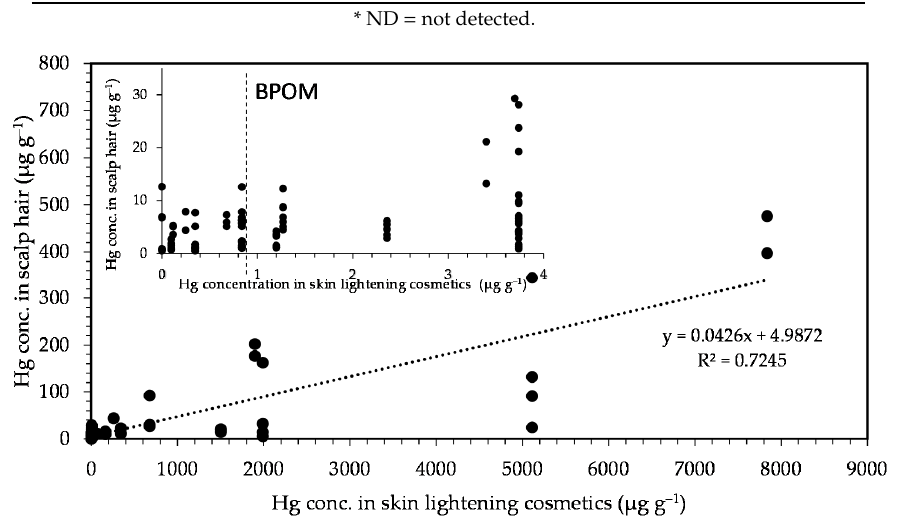
Figure 2. Correlation between Hg in hair and cosmetics in the students’ scalp hair and cosmetics. An inserted graph is the magnification scale in the rectangular area projecting the Hg concentration limit in skin-lightening cosmetic products determined by BPOM.